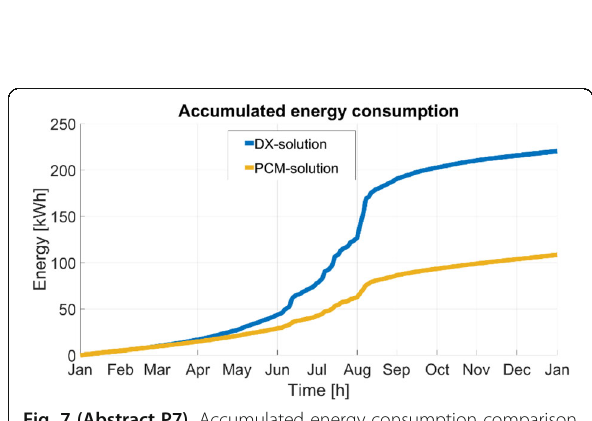
Fig. 7 (Abstract P7). Accumulated energy consumption comparison between PCM module and DX solution